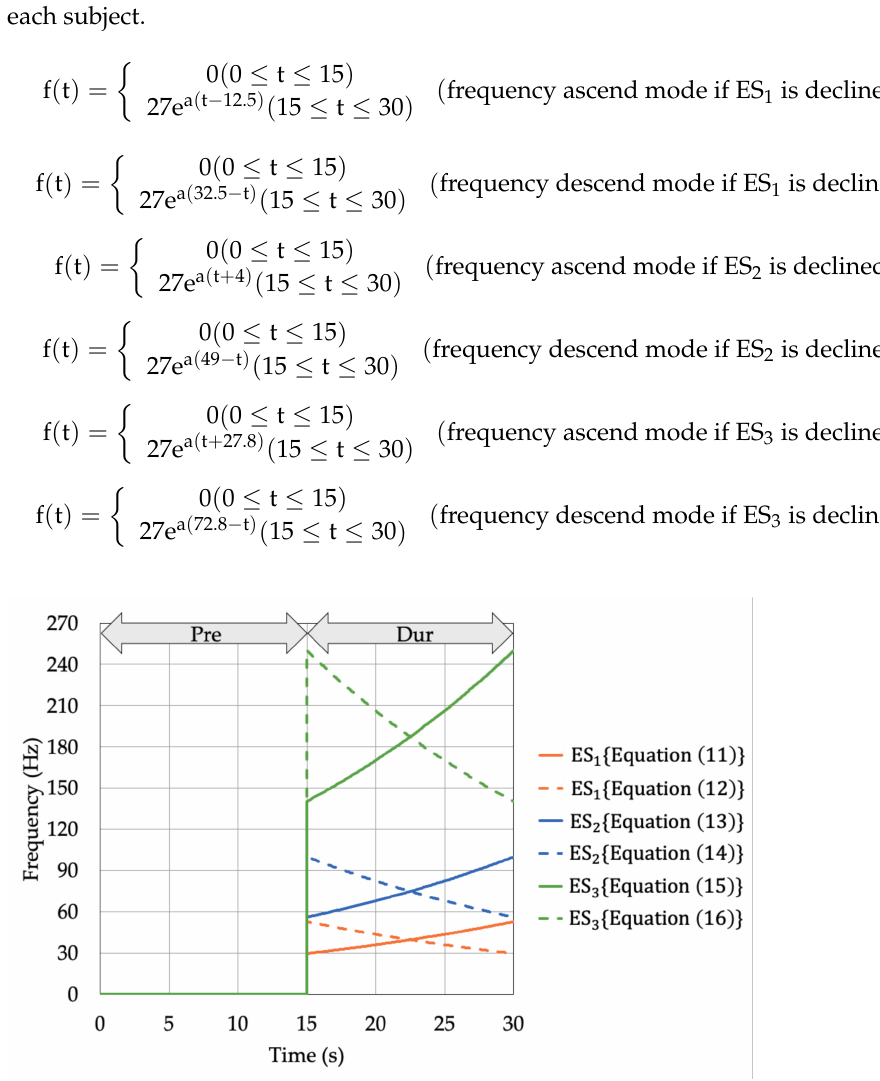
Figure 5. Specific sweep frequency of local vibratory stimulation. ES = evaluation sections. The subscript numbers of ES are indicated as follows: 1 = muscle spindles (lower frequency), from 30 to 53 Hz; 2 = muscle spindles (higher frequency), from 56 to 100 Hz; 3 = Vater-Pacini corpuscle, from 140 to 250